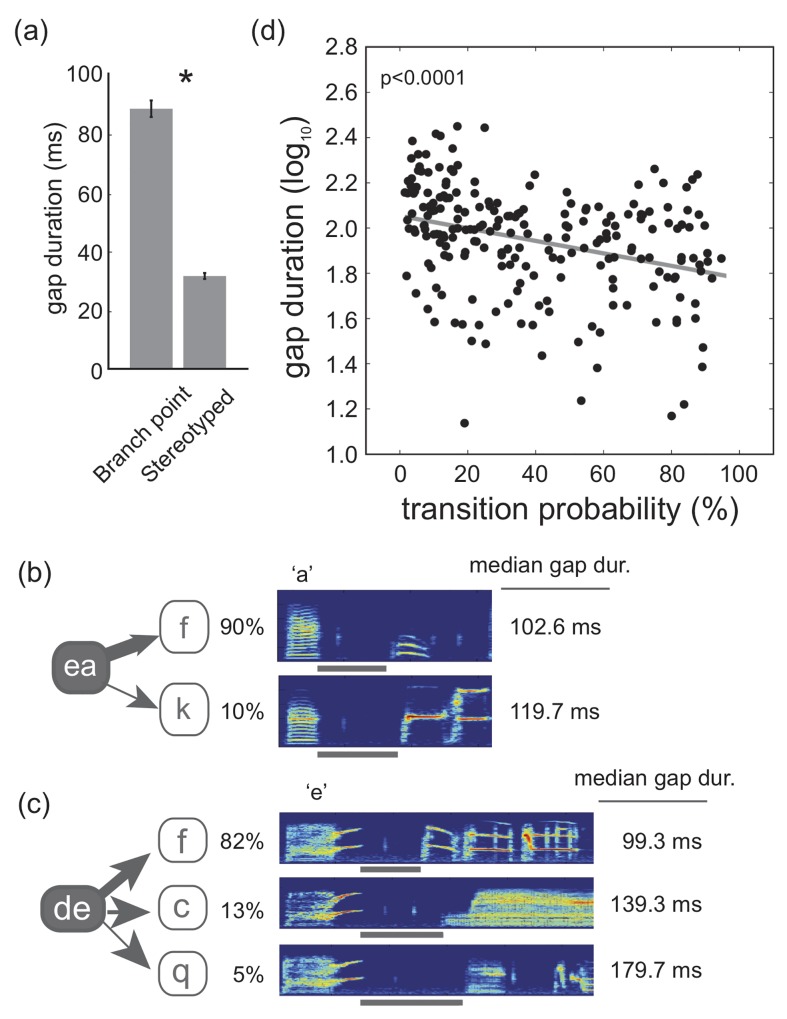
Inverse relationship between transition probability and gap durations.(a). Gap durations were significantly shorter for transitions within stereotyped sequences (transition probabilities >95%) than for transitions within branch points (transition probabilities <95%). Analyses were conducted on log10-transformed data but presented here are back-transformed means. (b). An example of variation in gap durations as a function of transition probability within a branch point. The bird transitioned from ‘ea’ to ‘k’ on 10% of renditions and to ‘f’ on 90% of renditions (same branch point depicted in Fig 1). The duration of the gap between ‘a’ and ‘k’ (the less prevalent transition) was longer than the gap between ‘a’ and ‘f’ (the more prevalent transition). Thickness of arrows relates to the prevalence of that transition. (c). Another example of variation in gap durations as a function of transition probability. The bird transitioned from ‘de to ‘f’ on 82% of renditions, to ‘c’ on 13% of renditions, and to ‘q’ on 5% of renditions. The duration of the gap between ‘e’ and ‘f’ (the most prevalent transition) was shortest, while the gap was longest between ‘e’ and ‘q’ (the least prevalent transition). Thickness of arrows relates to the prevalence of that transition. (d). There was a significant negative relationship between transition probability and log10 gap duration (F1,144.6 = 29.1, p<0.0001; slope = -0.240±0.044).